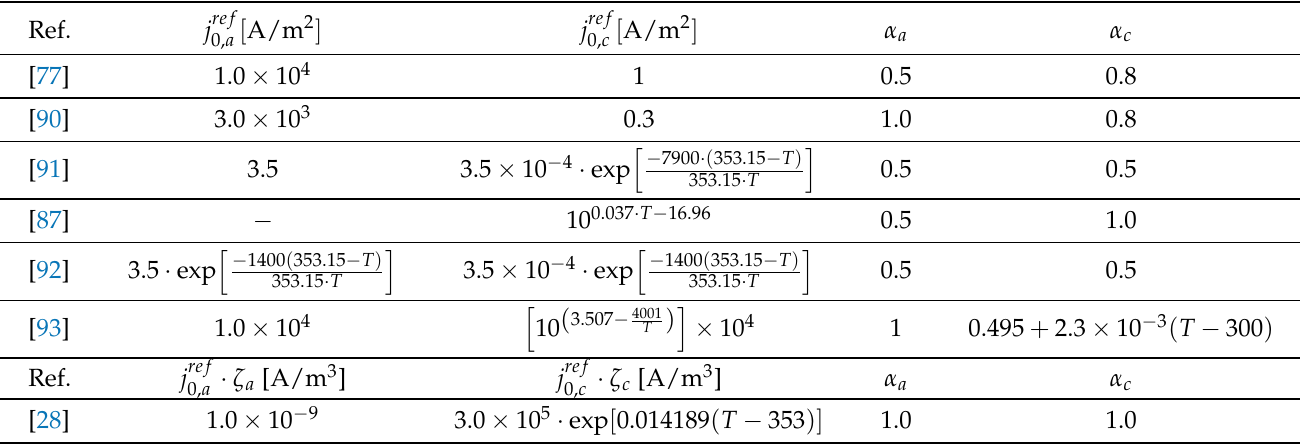
Table 13. Exchange current density and transfer coefficients from literature. The table continues in the bottom part for additional references and variables.